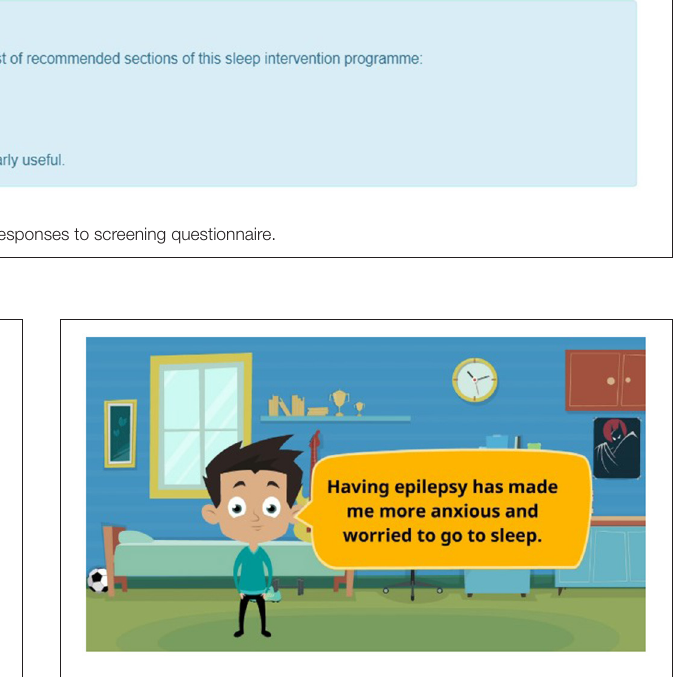
FIGURE 4 | Still from COSI animation demonstrating integration of child perspective (quote).